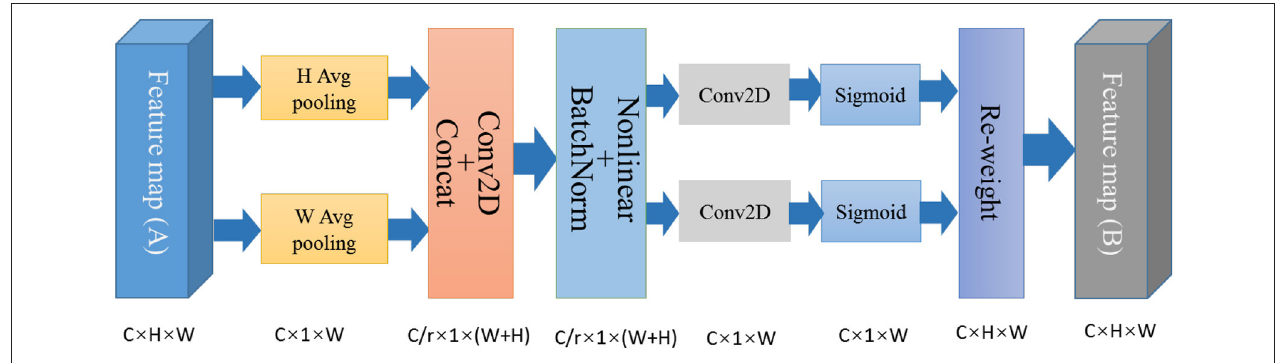
FIGURE 3 | Schematic of coordinate attention